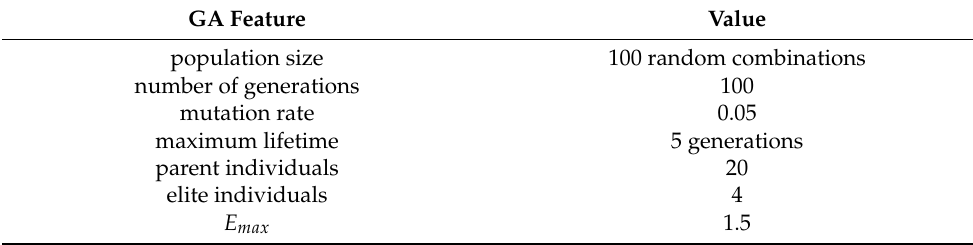
Table 1. Features of the